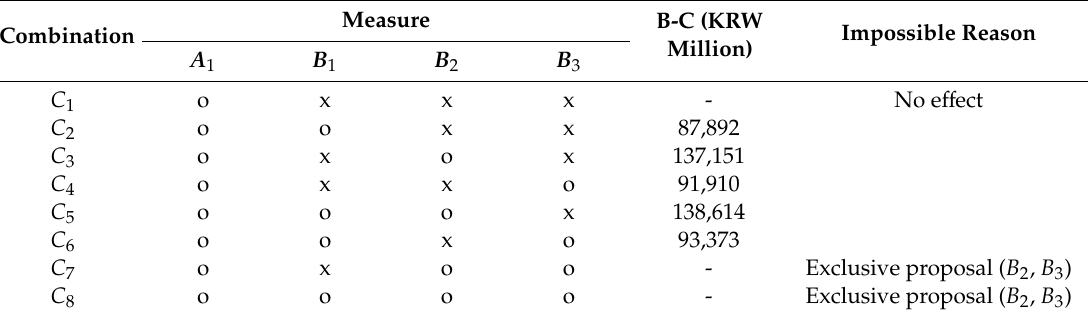
Table 5. Combination of viable flood